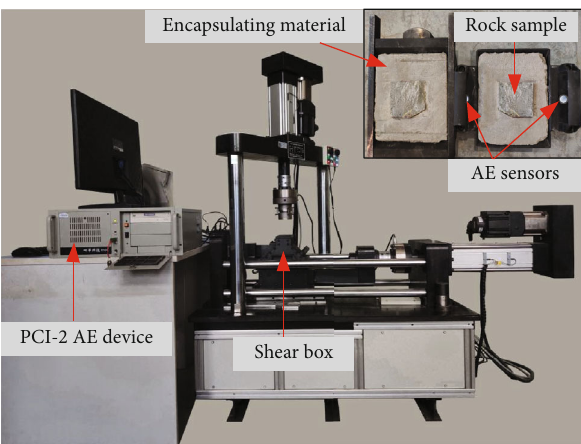
Figure 2: Rock shear testing system and PCI-2 acoustic emission